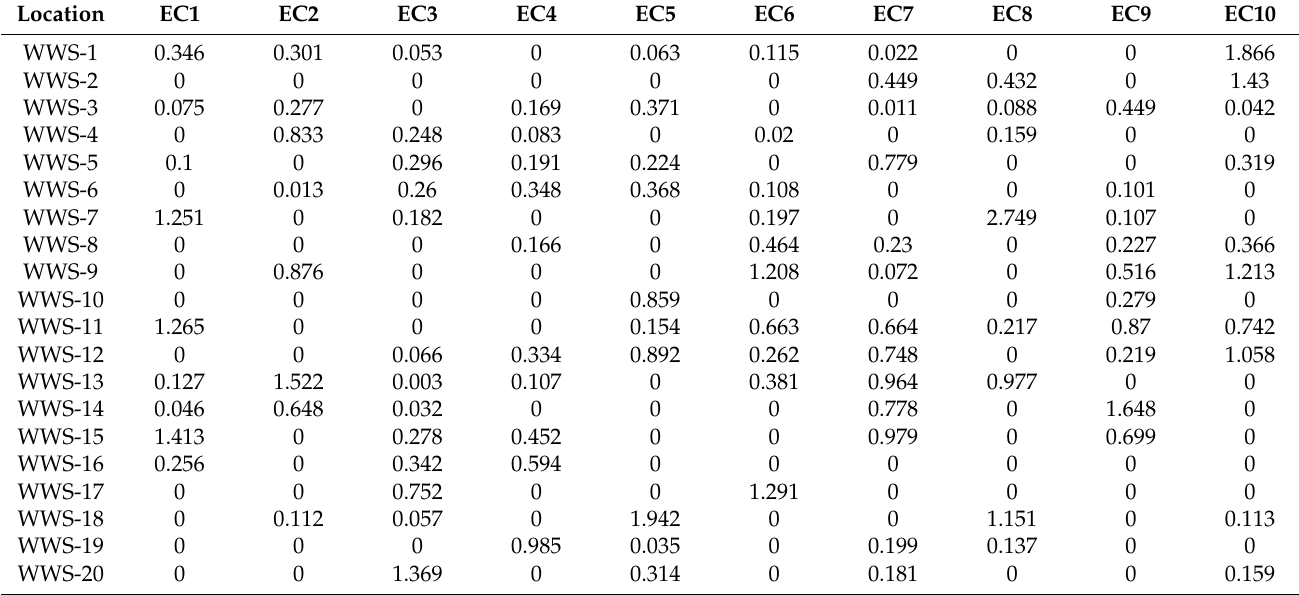
Table A9. Positive distance from average solution.